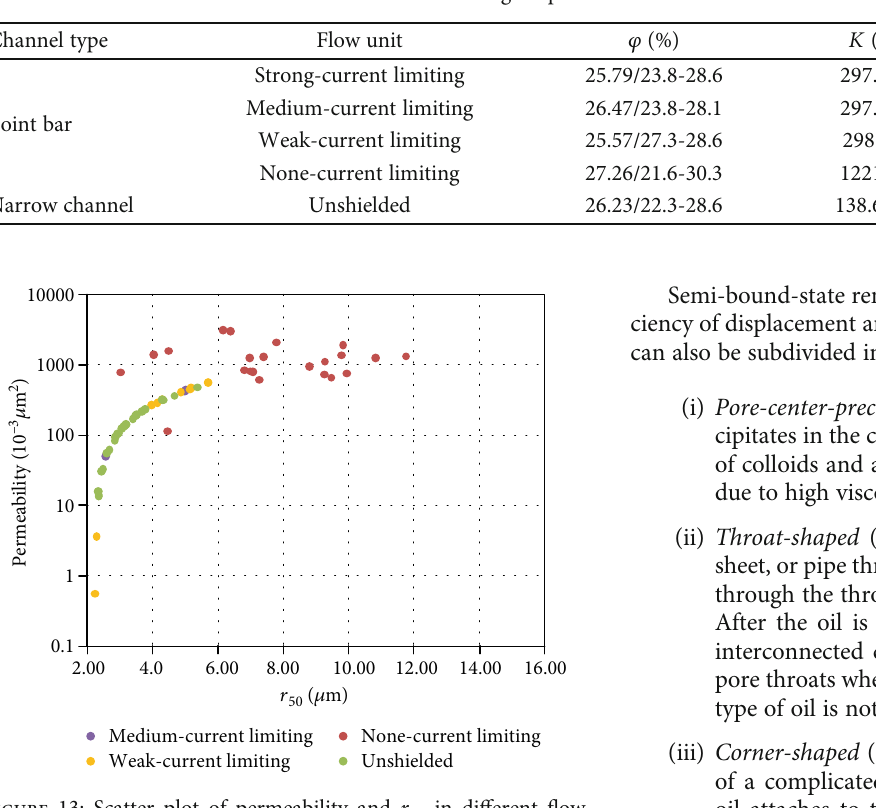
in di ff erent fl ow 50